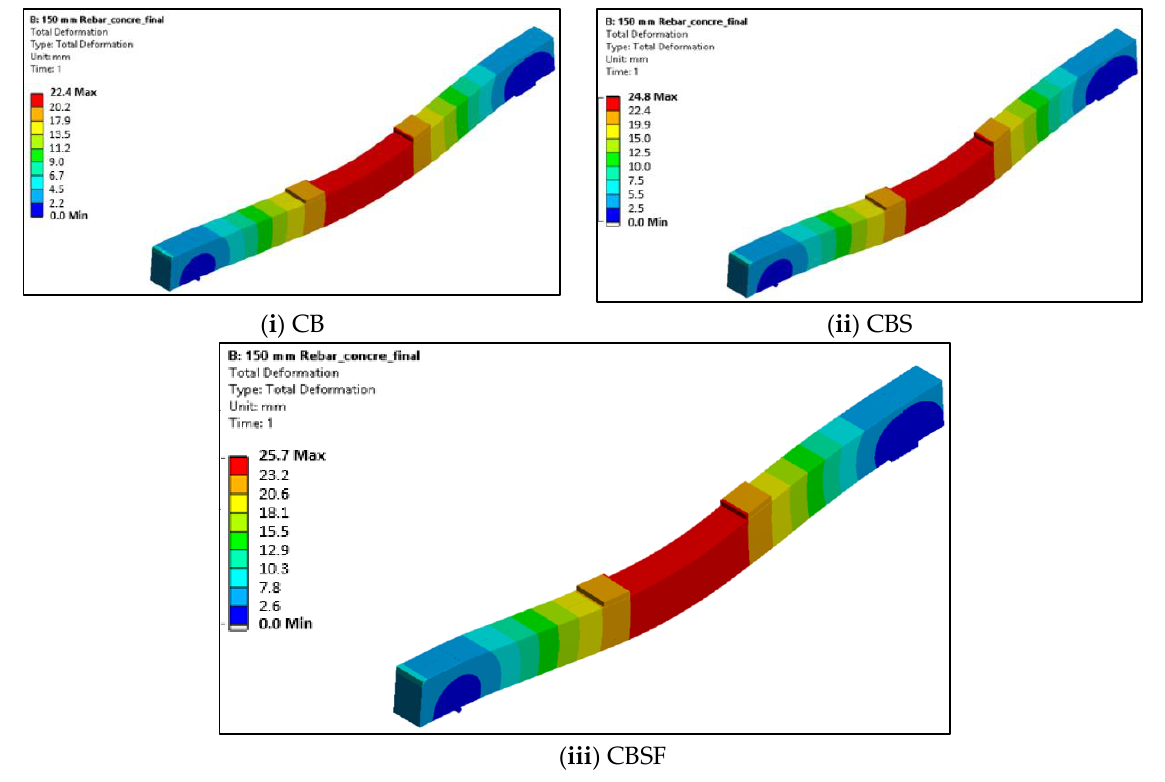
Figure 20. Deflected shapes of the plain CFS beams.